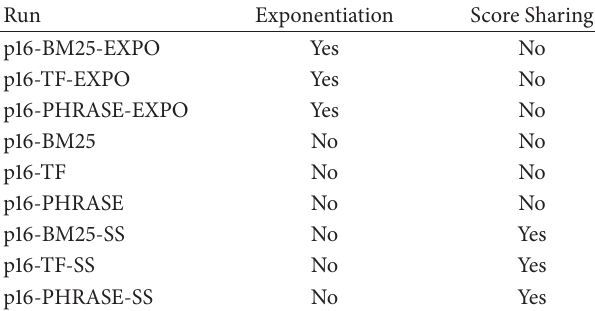
Table 3: The details of experiments.